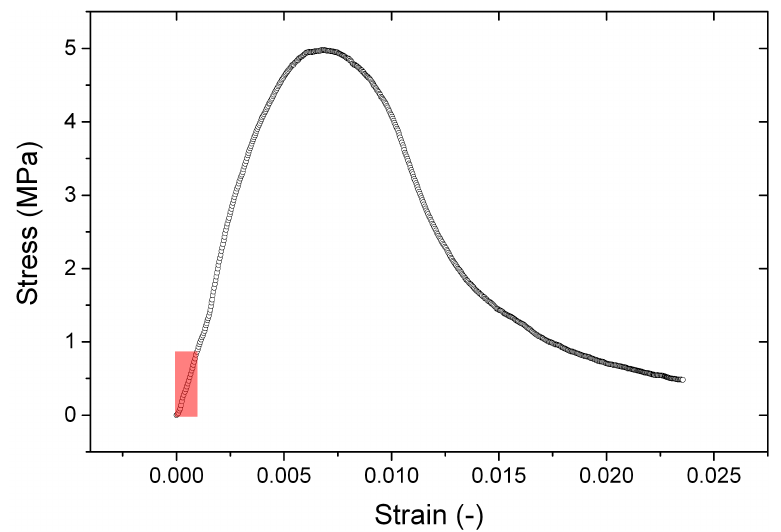
Figure 4. Typical stress-strain curve of the artificial stone. Note the high critical deformation. The red rectangle indicates the area of stress and strain investigated during the relaxation tests.